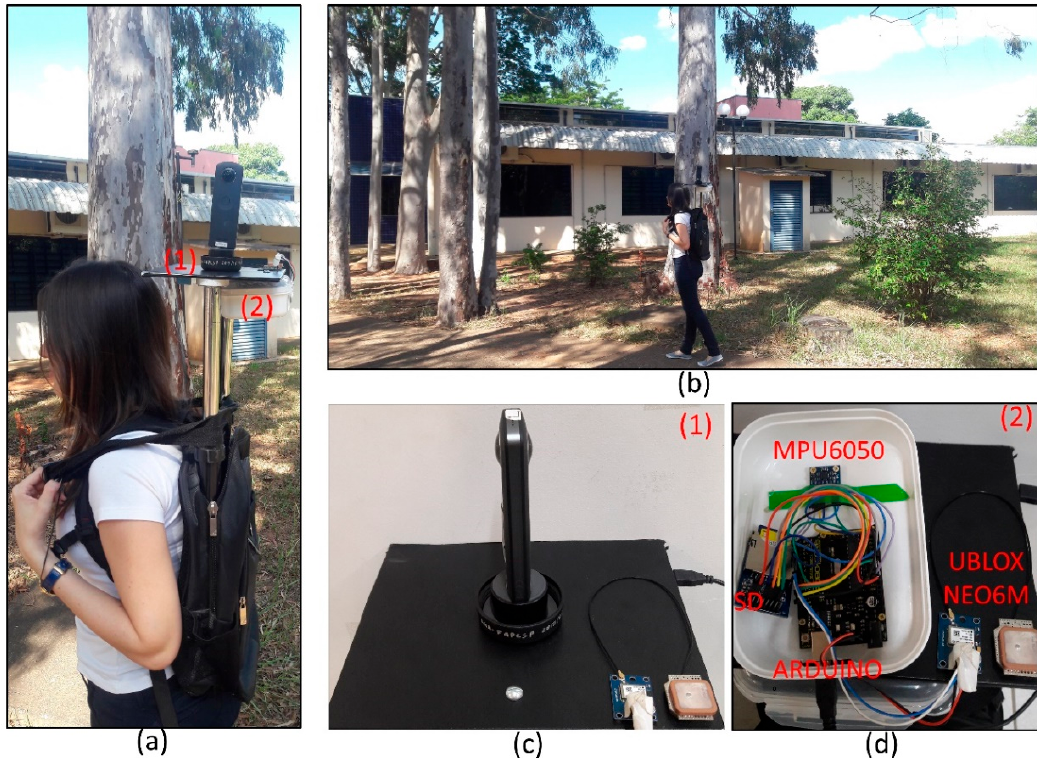
Figure 5. Personal mobile terrestrial system (PMTS) for a sequential data acquisition: ( a ) PMTS imaging and navigation sensors, ( b ) PMTS carried by an operator in the test area (dataset III), ( c ) Ricoh Theta S camera, and ( d ) navigation sensors.